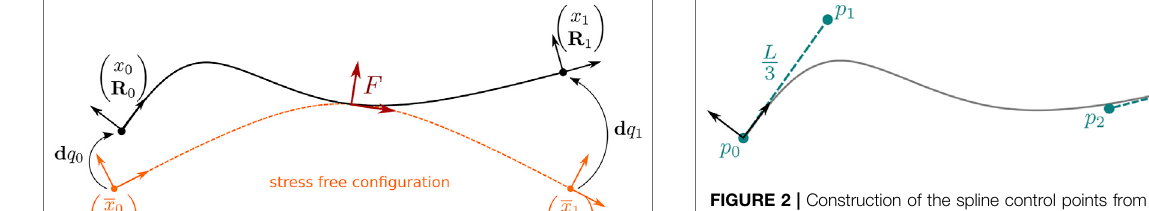
FIGURE 2 | Construction of the spline control points from the beam end